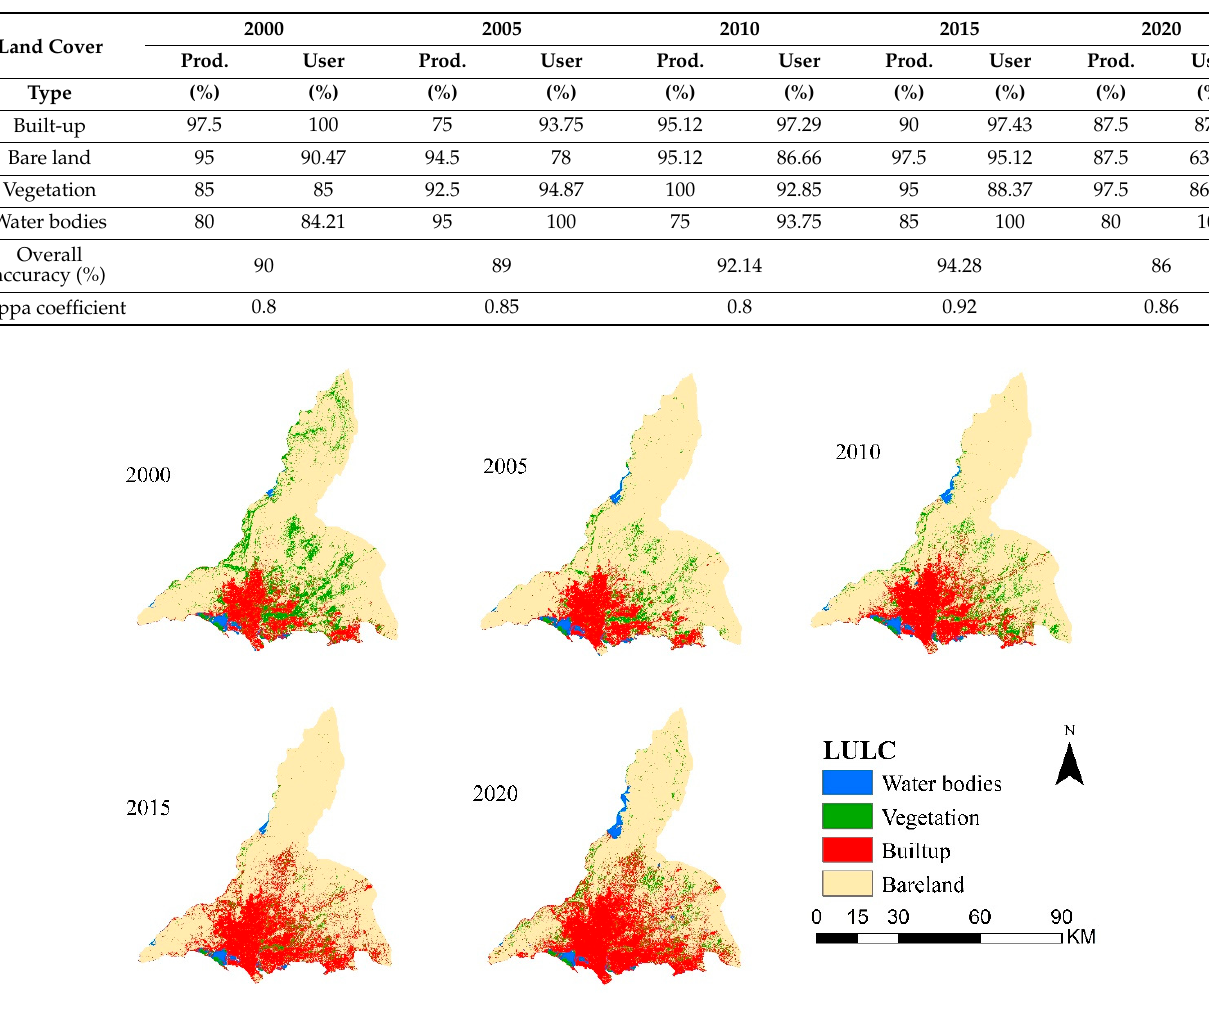
Figure 3. LULC maps of the study area estimated from Landsat data for the years 2000, 2005, 2010, 2015, and 2020. Table 3. Accuracy assessment of the classified